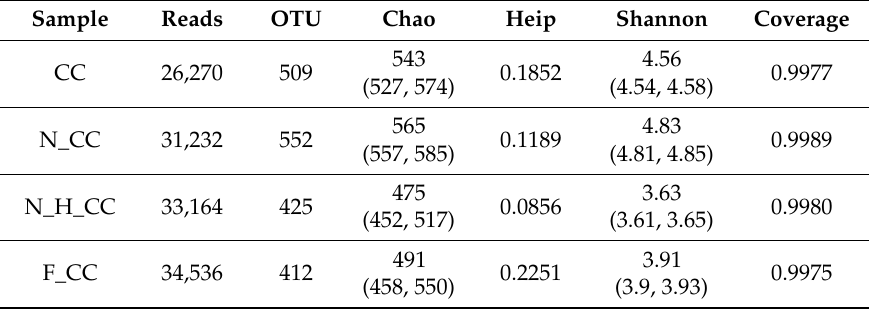
Table 1. Similarity based OTUs and species richness